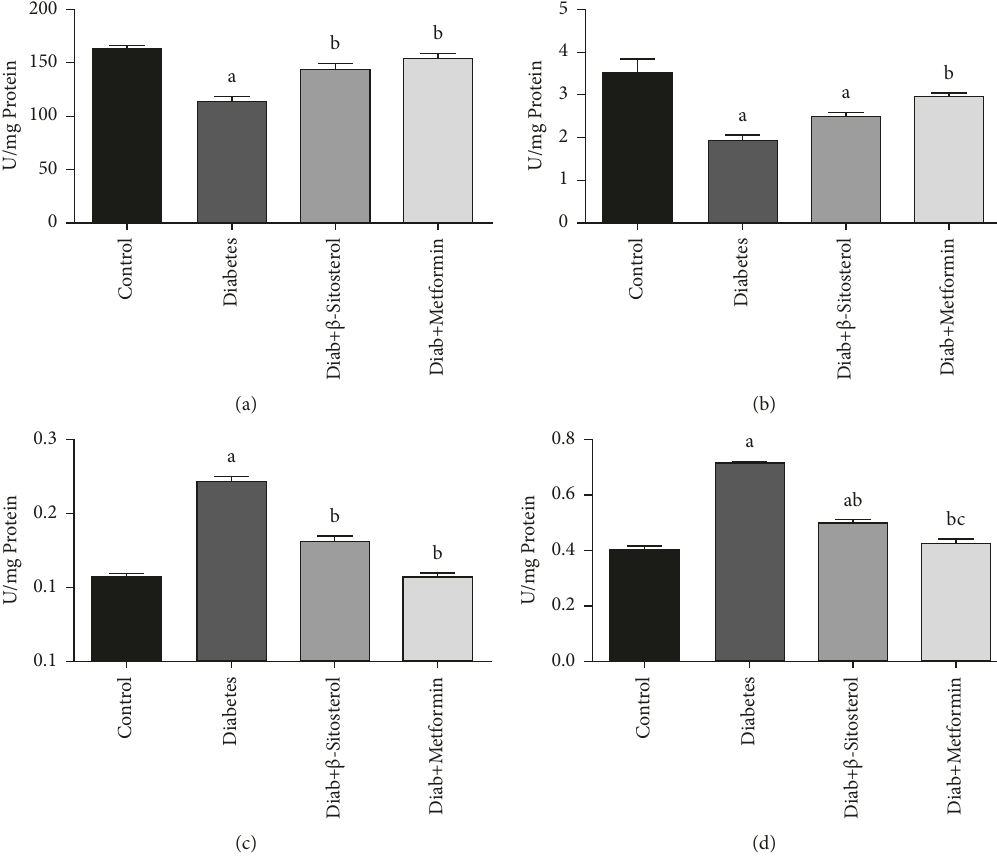
Figure 4: (a–d): Effect of β -sitosterol on the activities of HK, PK, G6P, and FBP enzymes in diabetic adult male rats on HFD and sucrose diet. Each bar indicates the mean ± SEM of 6 different animals. Values are compared as a—control, b—diabetic control, and c— β -sitosterol- treated diabetic group at p < 0 . 05 significance. (a) Hexokinase. (b) Pyruvate kinase. (c) Glucose-6-phosphatase. (d) Fructose-1,6